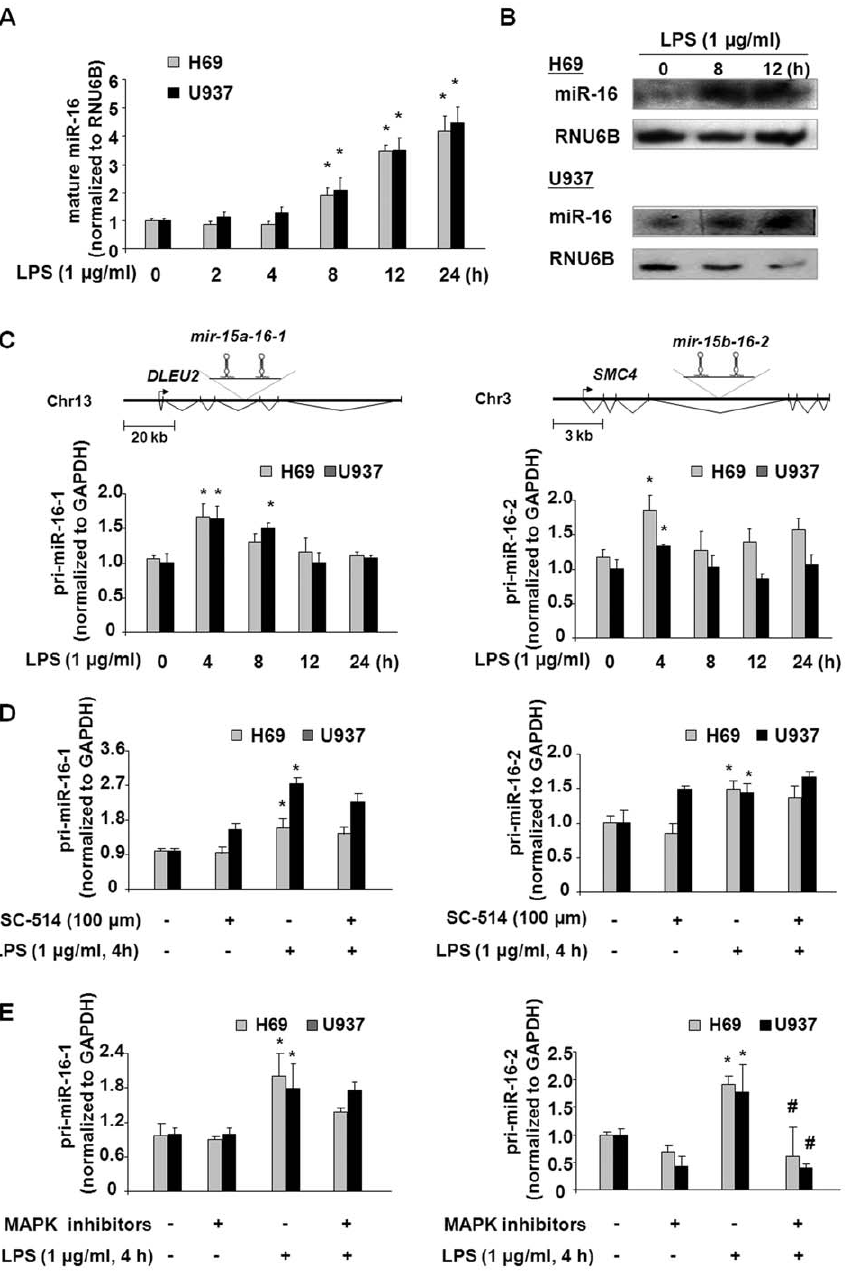
Figure 1. LPS stimulation increases miR-16 gene transcription in a MAPK-dependent but NF- k B-independent manner. (A) Alterations in mature miRNA-16 expression in H69 and U937 cells after exposure to LPS for various periods of time as assessed by real-time PCR. The level of mature miR-16 was obtained by normalizing the reactions to the level of snRNA RNU6B. Data are expressed as the amount of mature miR-16 in LPS- stimulated samples relative to the control non-stimulated samples. Results are averages of three independent experiments. (B) Alterations of miRNA- 16 expression in cells after exposure to LPS for 8 h and 12 h, as determined by Northern blot. snRNA RNU6B was used as a control to ensure equal loading between lanes. Representative Northern blots (LPS-stimulated cells vs. non-stimulated control) from three independent experiments are shown. (C) Kinetics of pri-miR-16-1 and pri-miR-16-2 in cells following LPS stimulation. The schematic diagrams show the structure of two miR-16 genes encoding pri-miR-16-1 and pri-miR-16-2, respectively. H69 and U937 cells were exposed to LPS for 4 h to 24 h, and pri-miR-16-1 and pri-miR- 16-2 levels were quantified by real-time PCR. (D) and (E) Effects of inhibitors to NF- k B and MAPK pathways on LPS-induced upregulation of pri-miR- 16-1 and pri-miR-16-2. The expression levels of pri-miRNA-16-1 and pri-miRNA-16-2 were quantified by real-time PCR in H69 and U937 cells following LPS stimulation for 4 h in the presence or absence of SC-514 or three MAPK signaling pathway inhibitors. The amount of pri-miRNAs in each sample was obtained by normalizing each sample to the level of GAPDH. Data shown are averages of three independent experiments. *, p , 0.05 t -test vs. the non-stimulated cells; # , p , 0.05 t -test vs. LPS-stimulated cells.